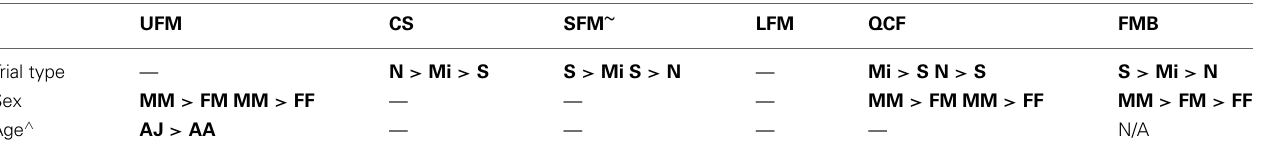
Table 3 | Differences in call prevalence based on trial type, sex combination, and age combination as determined by Pearson’s Chi-Square